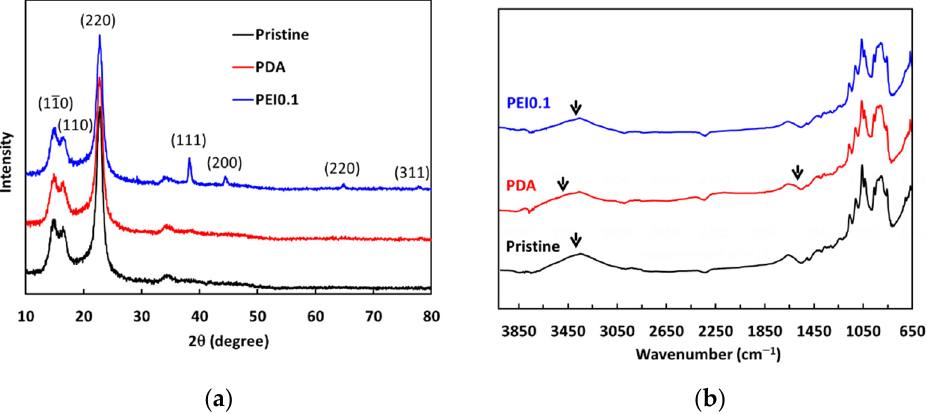
Figure 4. ( a ) XRD spectra and ( b ) ATR-FITR spectra of as-prepared filter papers.